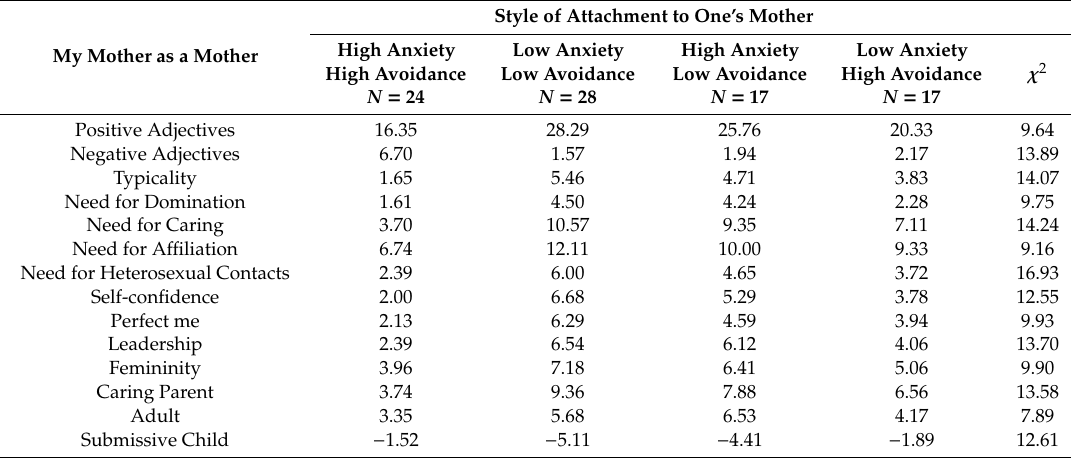
Table 2. Significant di ff erences in the representation of one’s mother as a mother among women with di ff erent styles of attachment to their